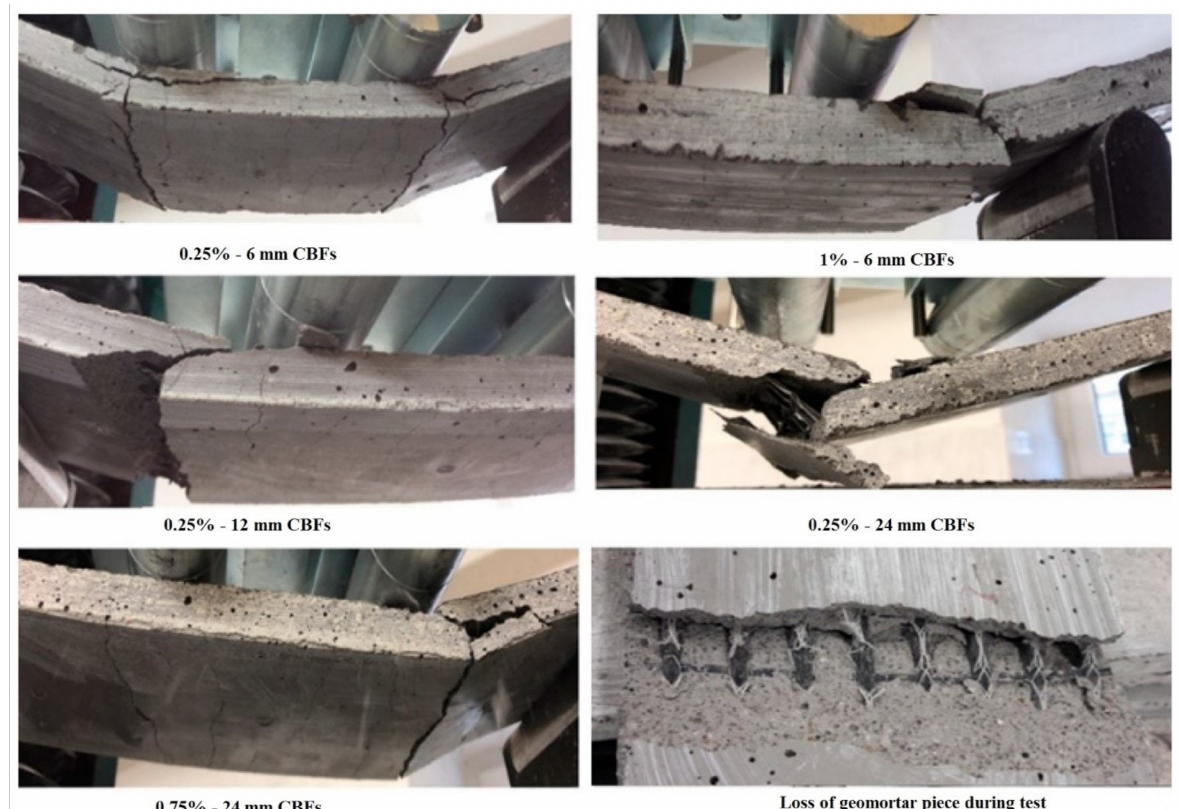
Figure 16. Four-point flexural strength test with varying fiber length of basalt chopped fibers. Reprinted with permission from Ref. [166]. Copyright 2021, with permission from